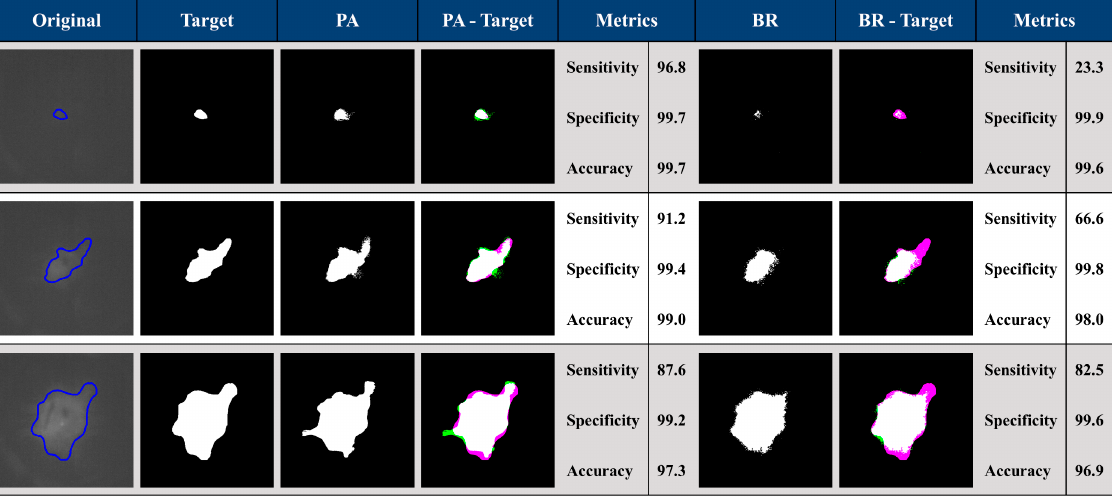
Figure 15. Evaluation of the metric at λ = 1.55 BDI.